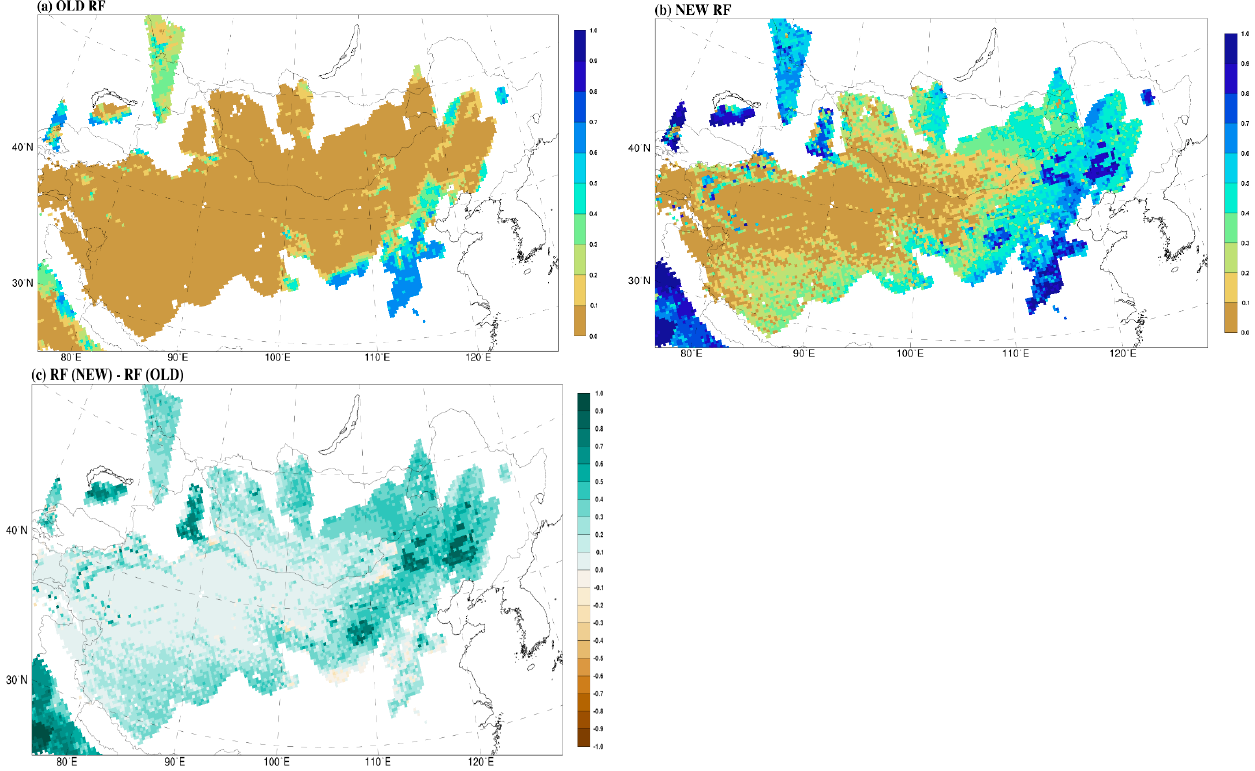
Figure 2. Spatial distribution of ( a ) OLD_RF and ( b ) NEW_RF over the Asian dust source regions retrieved from the Spot4/vegetation and real-time MODIS NDVI data, respectively. ( c ) Spatial distribution of the RF difference between NEW_RF and OLD_RF.